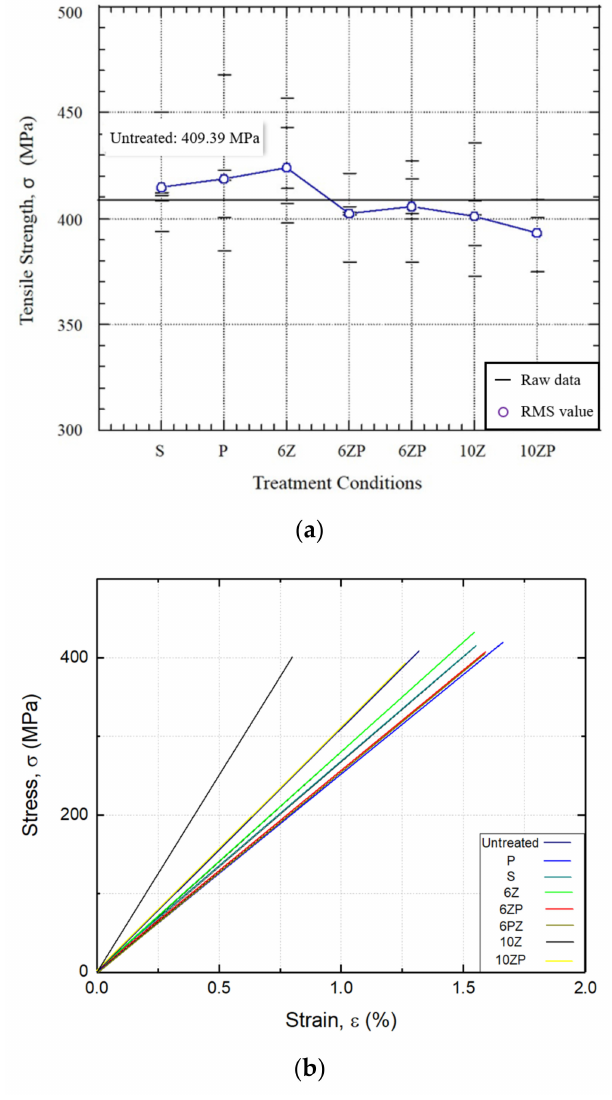
Figure 9. Tensile strength and stress–strain curve of the 6-layer aramid fabric under various conditions. ( a ) Tensile strength, ( b )